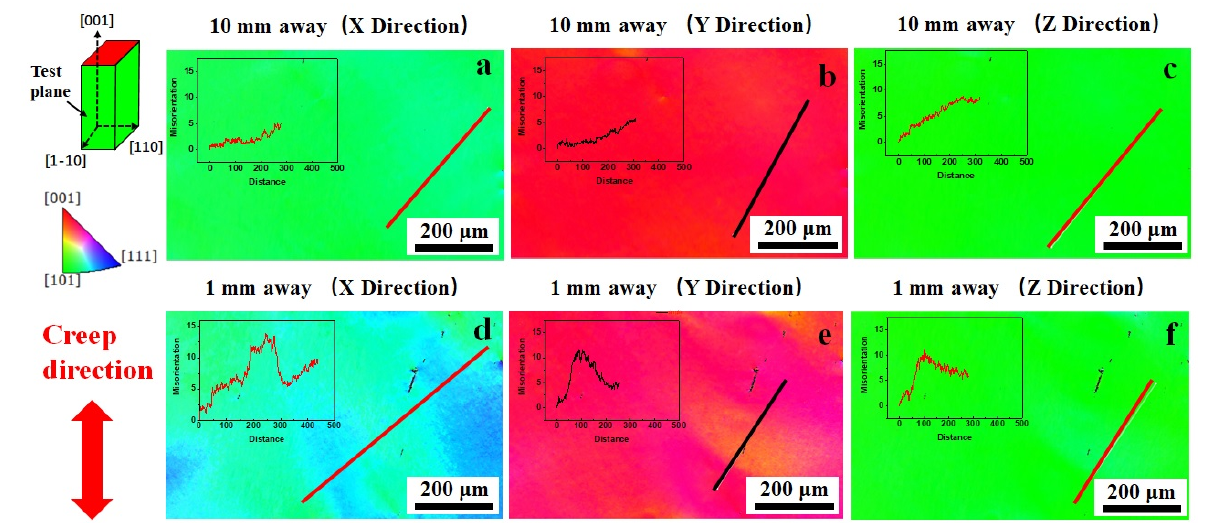
Figure 5. EBSD inverse pole figure of the region which is 10 mm away from the fracture surface ( a ) X direction; ( b ) Y direction; ( c ) Z direction; EBSD inverse pole figure of the region which is 1 mm away from the fracture surface ( d ) X direction; ( e ) Y direction; ( f ) Z direction.